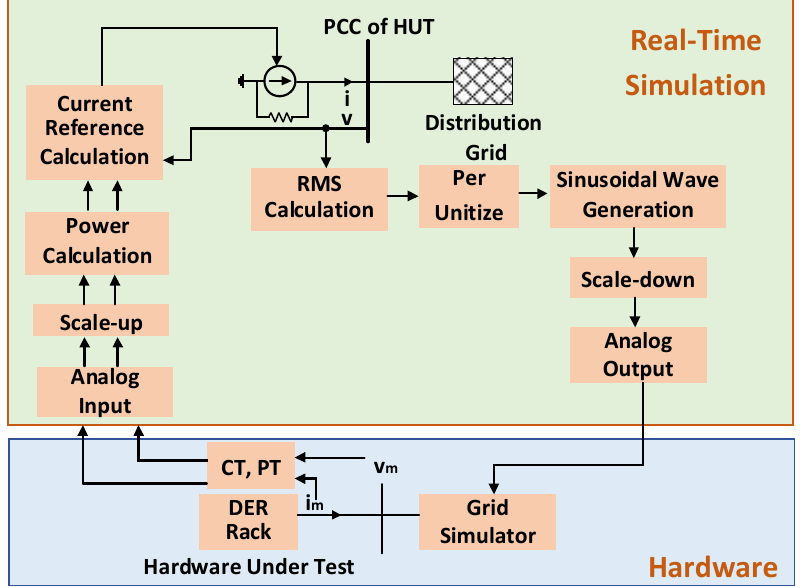
Figure 7. The PHIL interface algorithm implemented in OPAL-RT.